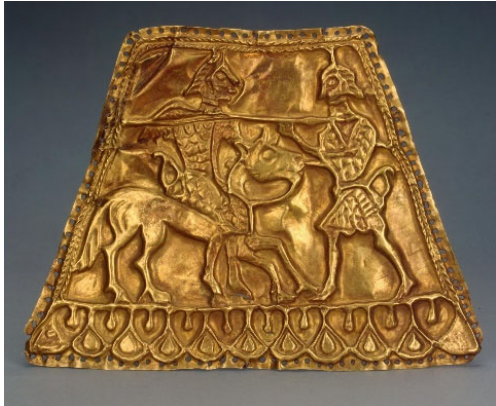
Figure 27. Gold plaque depicting a battle (SHM inv. no. Дн .1859 ‐ 1/2); gold; Geremesov